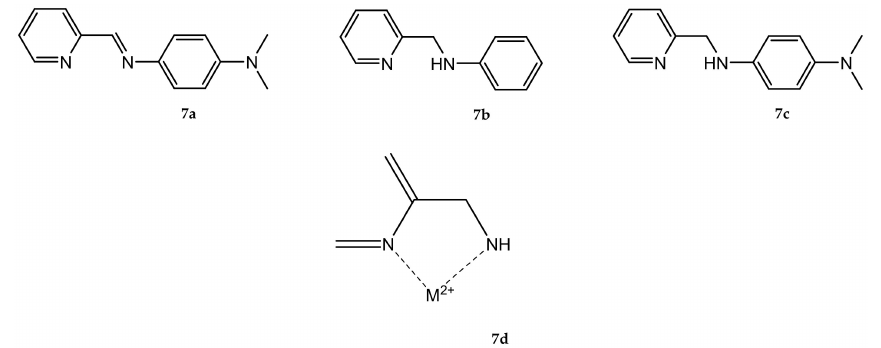
Figure 7. Bifunctional molecules for the treatment of Alzheimer’s disease (AD) and their supposed chelation mechanism ( 7d )